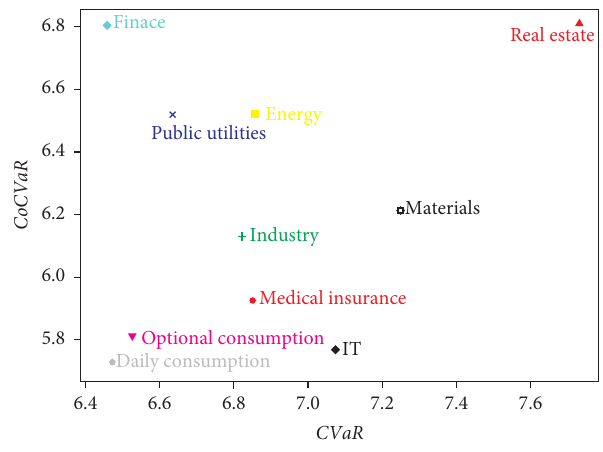
Figure 8: CVaR vs. CoCVaR by